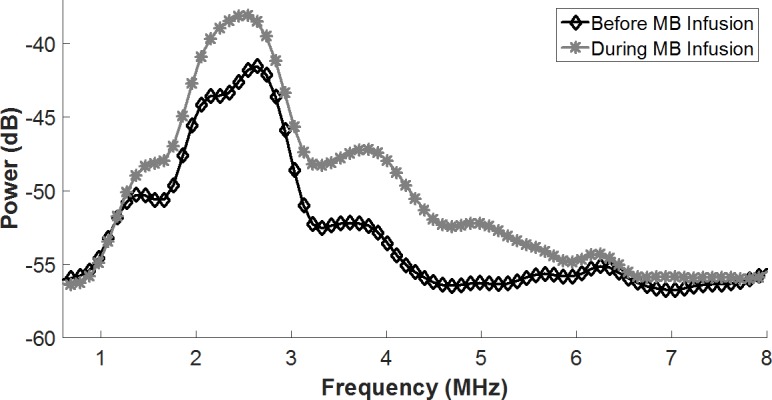
Microbubble Cavitation in Mouse Heart.Average acoustic emissions in a single, representative mouse upon ultrasound delivery before (◊) and during (•) MB infusion. Broadband increase in average acoustic emissions during MB infusion indicates the presence of MB inertial cavitation.